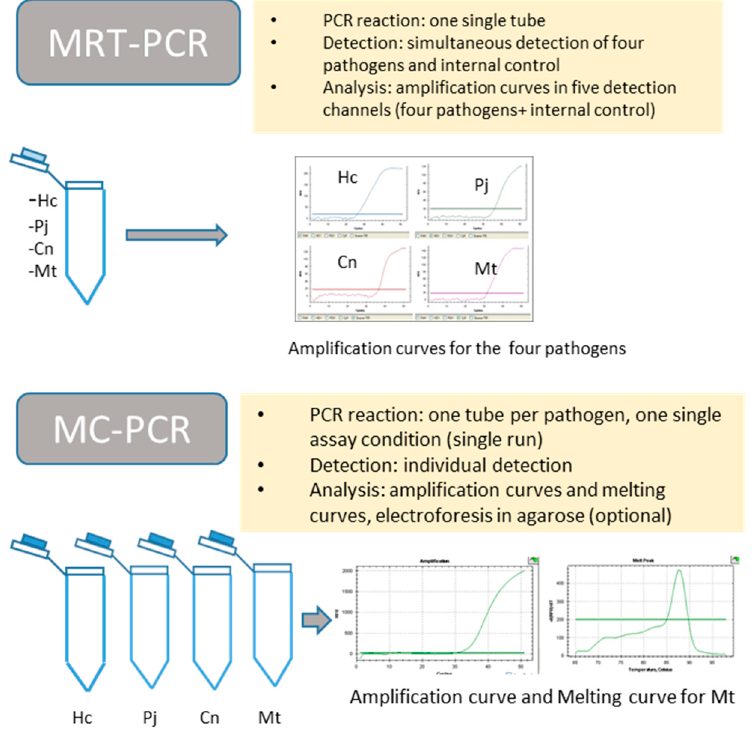
Figure 1. Concept of each assay, pointing out the differences between them. MRT-PCR, multiplex real-time PCR; MC-PCR, melting curve